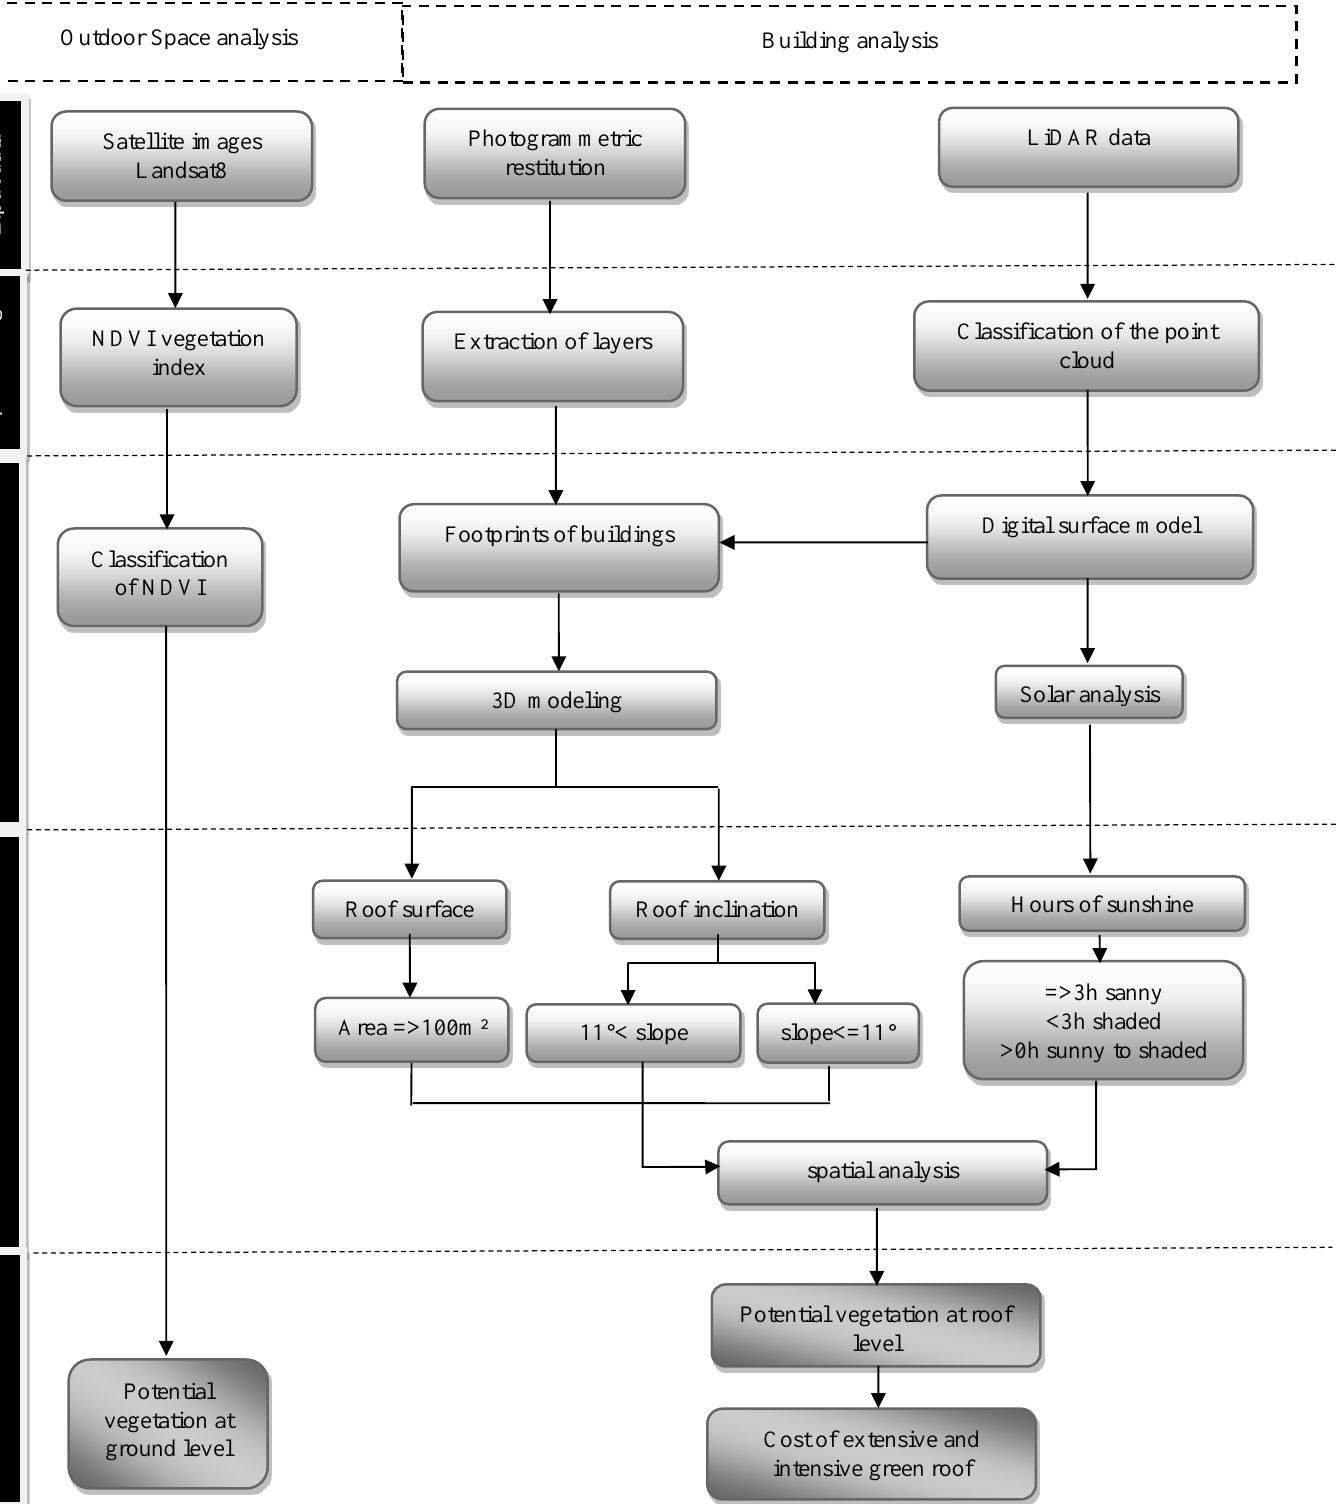
Figure 2. Flowchart for the Evaluation of green spaces potential in the city of